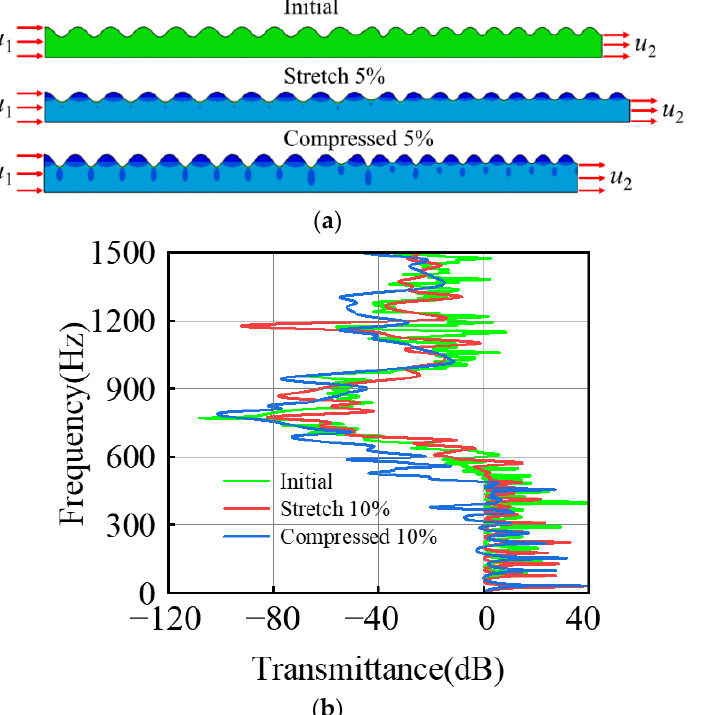
Figure 13. Influence of a 5% external load on the system: ( a ) deformation under a 5% tensile and compressive load; ( b ) transmission characteristic curve.